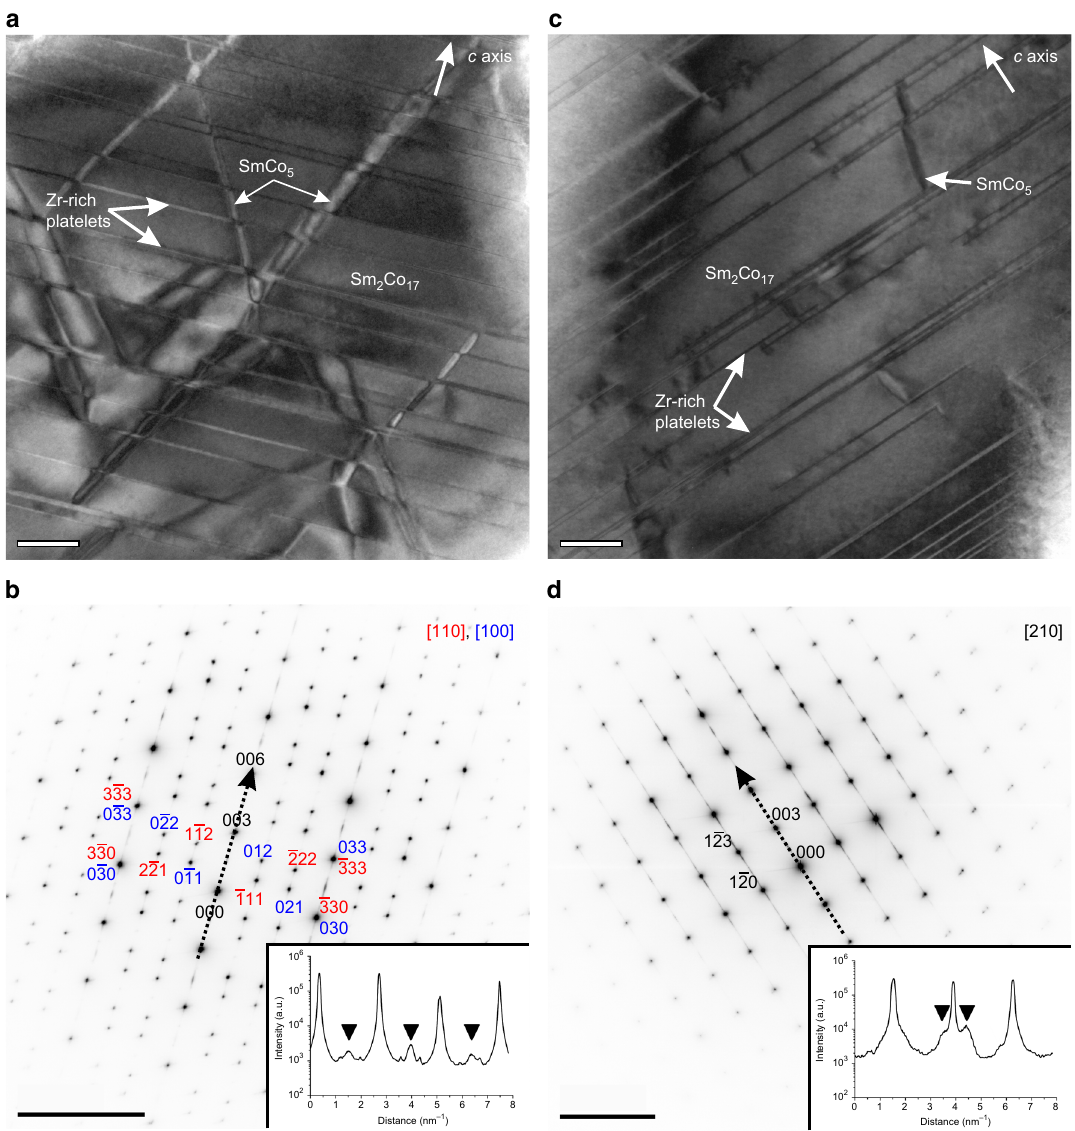
Fig. 1 Nanoscale phase distribution. a Bright- fi eld TEM image of sample 1. b Corresponding selected area electron diffraction pattern along the [110] zone axis (red text labels) with additional re fl ections from a [100] oriented twin (blue text labels). The superstructure re fl ections of type {0,0,3/2} along the hexagonal c -axis are denoted in the line pro fi le shown in the inset of b . c Bright- fi eld TEM image of sample 2. d Corresponding selected area diffraction pattern along the [210] zone-axis. Note the difference in ordering in the line pro fi le inset in d compared to the line pro fi le shown in the inset in b . The scales bars in the TEM images correspond to 50 nm. The scale bars in the electron diffraction patterns correspond to 5 nm −